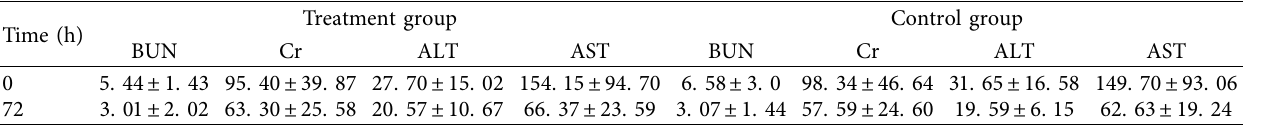
Table 4: Hepatorenal